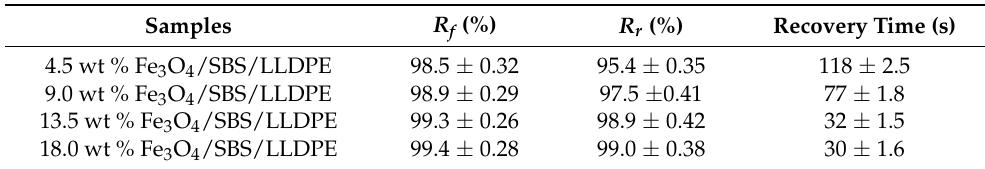
Table 1. Shape memory properties of the Fe 3 O 4 /SBS/LLDPE composites in an alternating magnetic field ( f = 60 kHz, H = 21.21 kA · m − 1